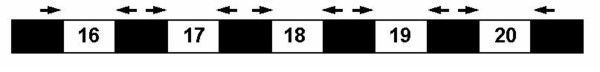
Schematic Diagram of Primer Design for Polymerase Chain Reaction. Forward and reverse primers (arrows) were designed in introns (black boxes) flanking exons 16, 17, 18, 19, and 20 (white boxes).